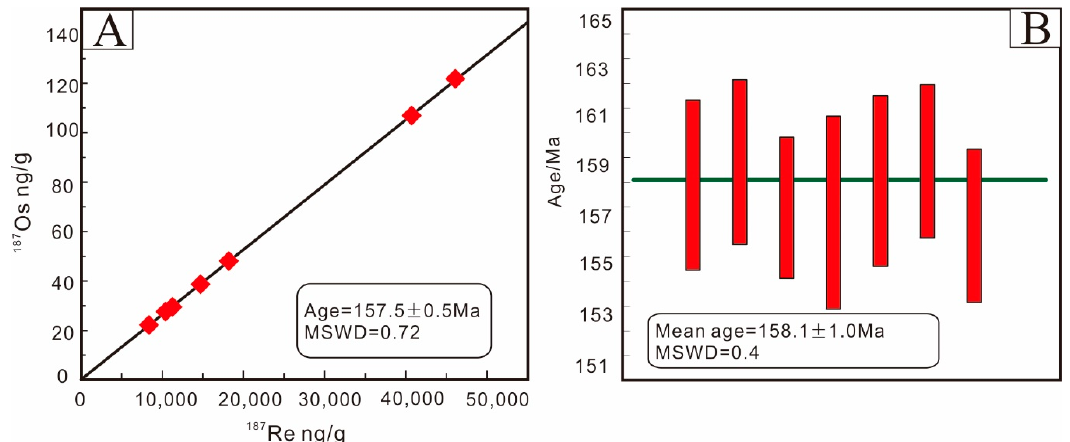
Figure 6. Re–Os isochron ( A ) and weighted average age ( B ) of molybdenite from the Jiangjiatun Mo deposit (Red box in Figure 6A and pillar in Figure 6B represents analytical sample of molybdenite; Green line in Figure 6B represents the weight mean of the individual molybdenite model ages).